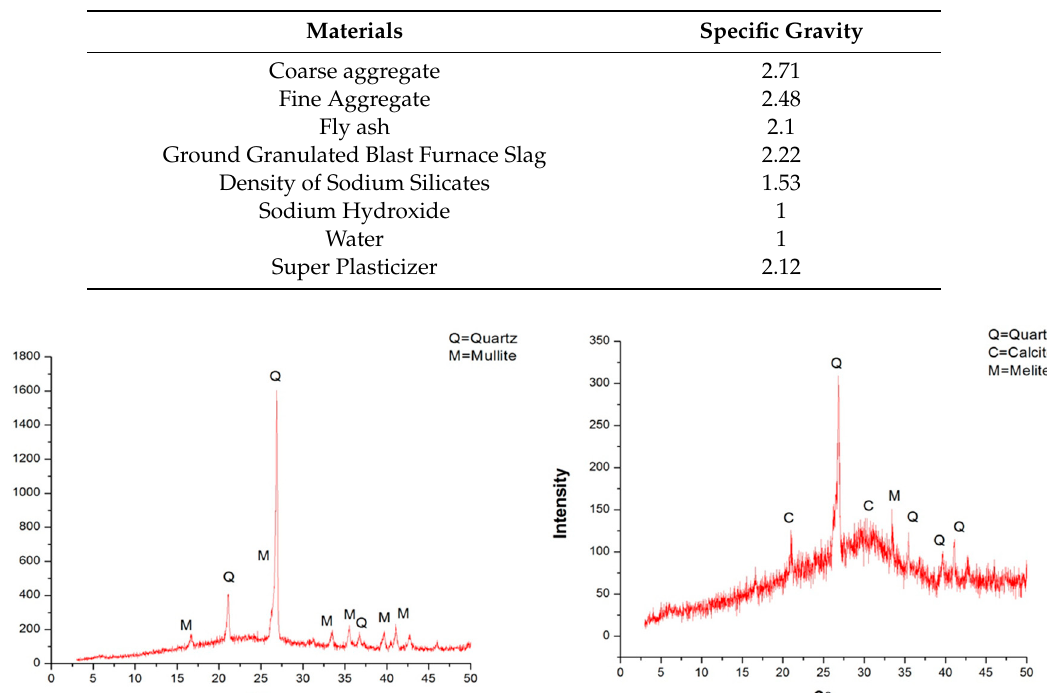
Figure 2. ( a ) Scanning electron microscope (SEM) image of fly ash at 50 µm, ( b ) SEM image of GGBFS at 20 µm.